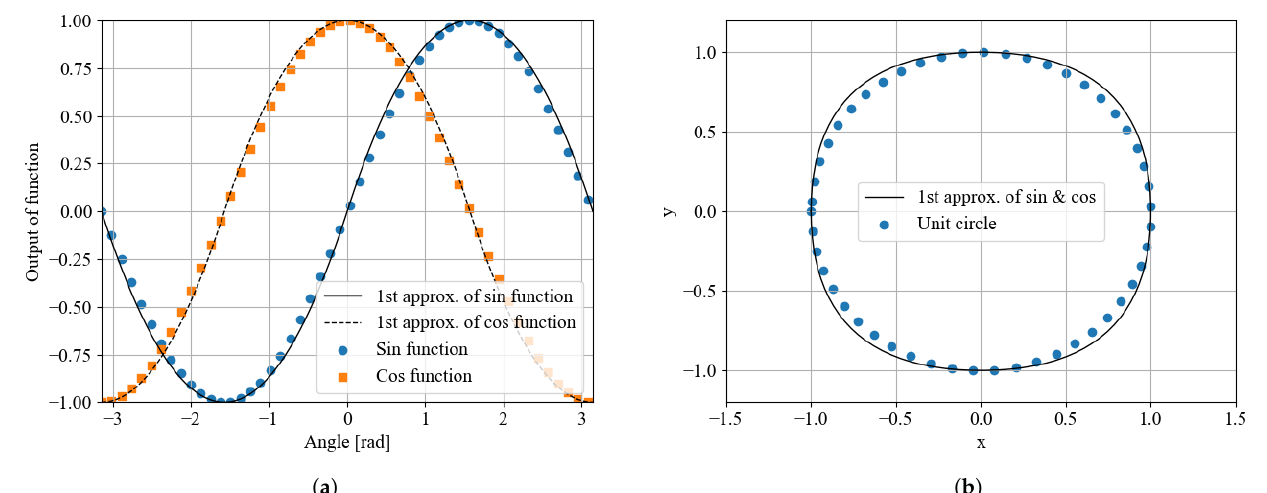
Figure 1. Summary of 1st approximations of sin-function and cos-function. ( a ) First approximation of sin and cos functions by RCM. ( b ) Comparison with unit